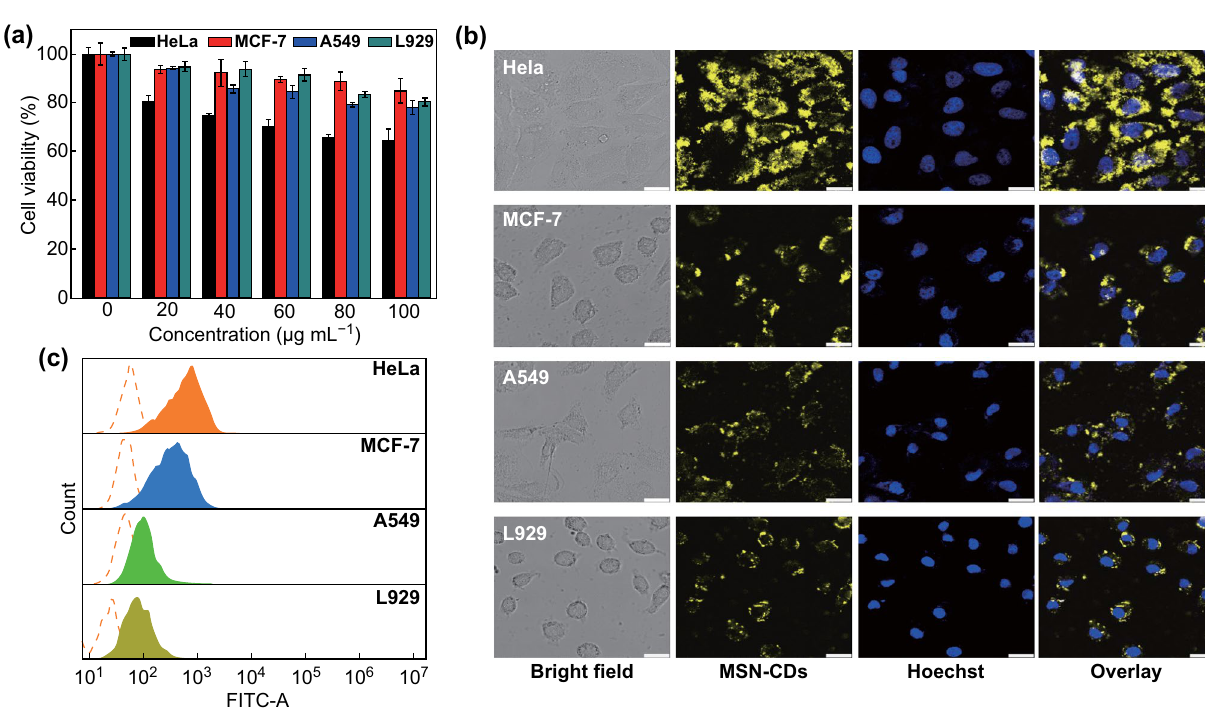
Fig. 4 a Cytotoxicity of MSNs–CDs at different concentrations (0, 20, 40, 60, 80, and 100 µg mL −1 ) toward four types of cells (HeLa, MCF-7, A549, and L929). b CLSM images and c flow cytometric analysis results of different cells incubated with 200 μg mL −1 of MSNs–CDs for 4 h. Scale bar in b is 25